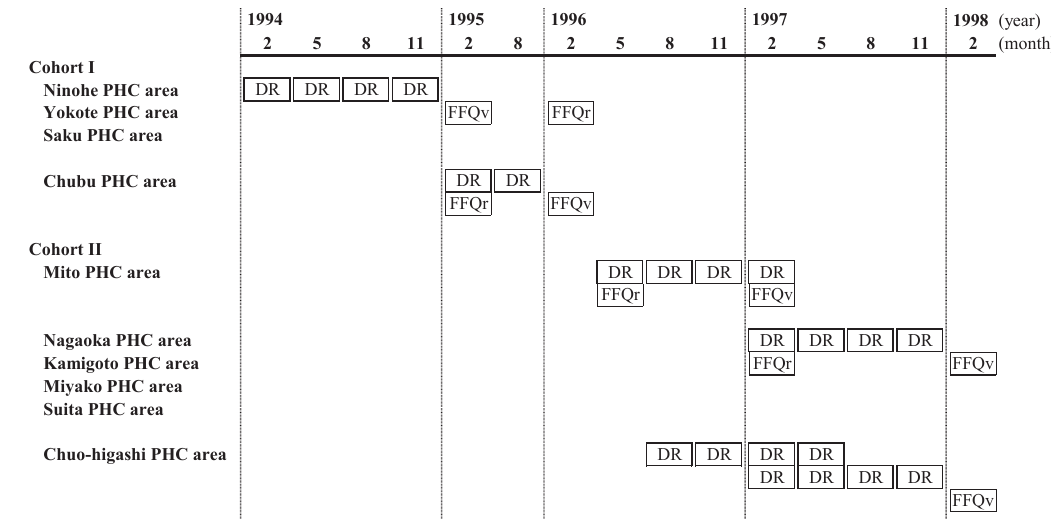
Fig. 1. The sequence of data collection. DR, dietary record; FFQ, food frequency questionnaire; PHC, Public Health